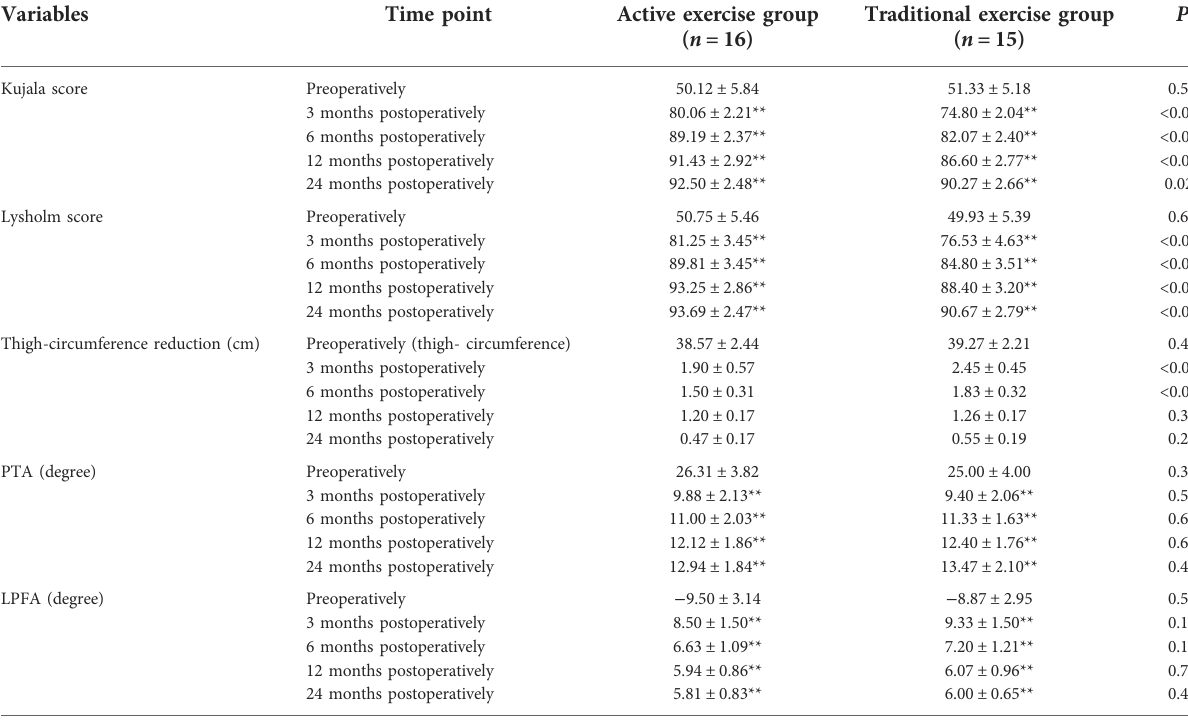
TABLE 2 Comparison of clinical outcomes between two groups.